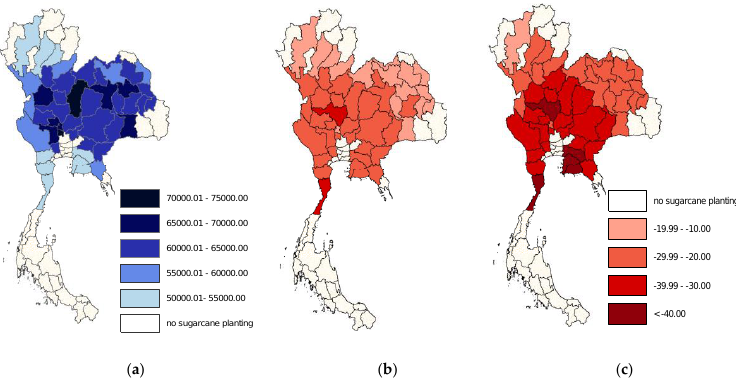
Figure 4. Projected percent changes in yield of sugarcane under climate change scenarios. ( a ) Baseline yield (kg/ha); ( b ) percent of change in yield under RCP4.5; ( c ) percent of change in yield under RCP8.5.